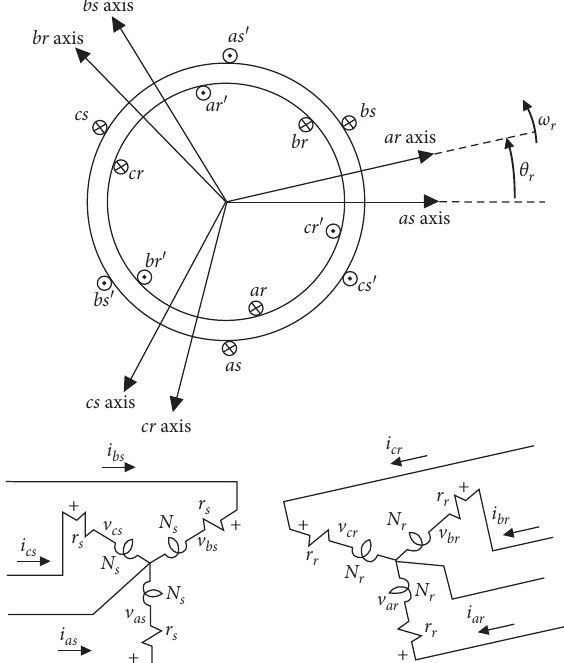
Figure 5: Schematic of symmetrical 3-phase asynchronous or induction